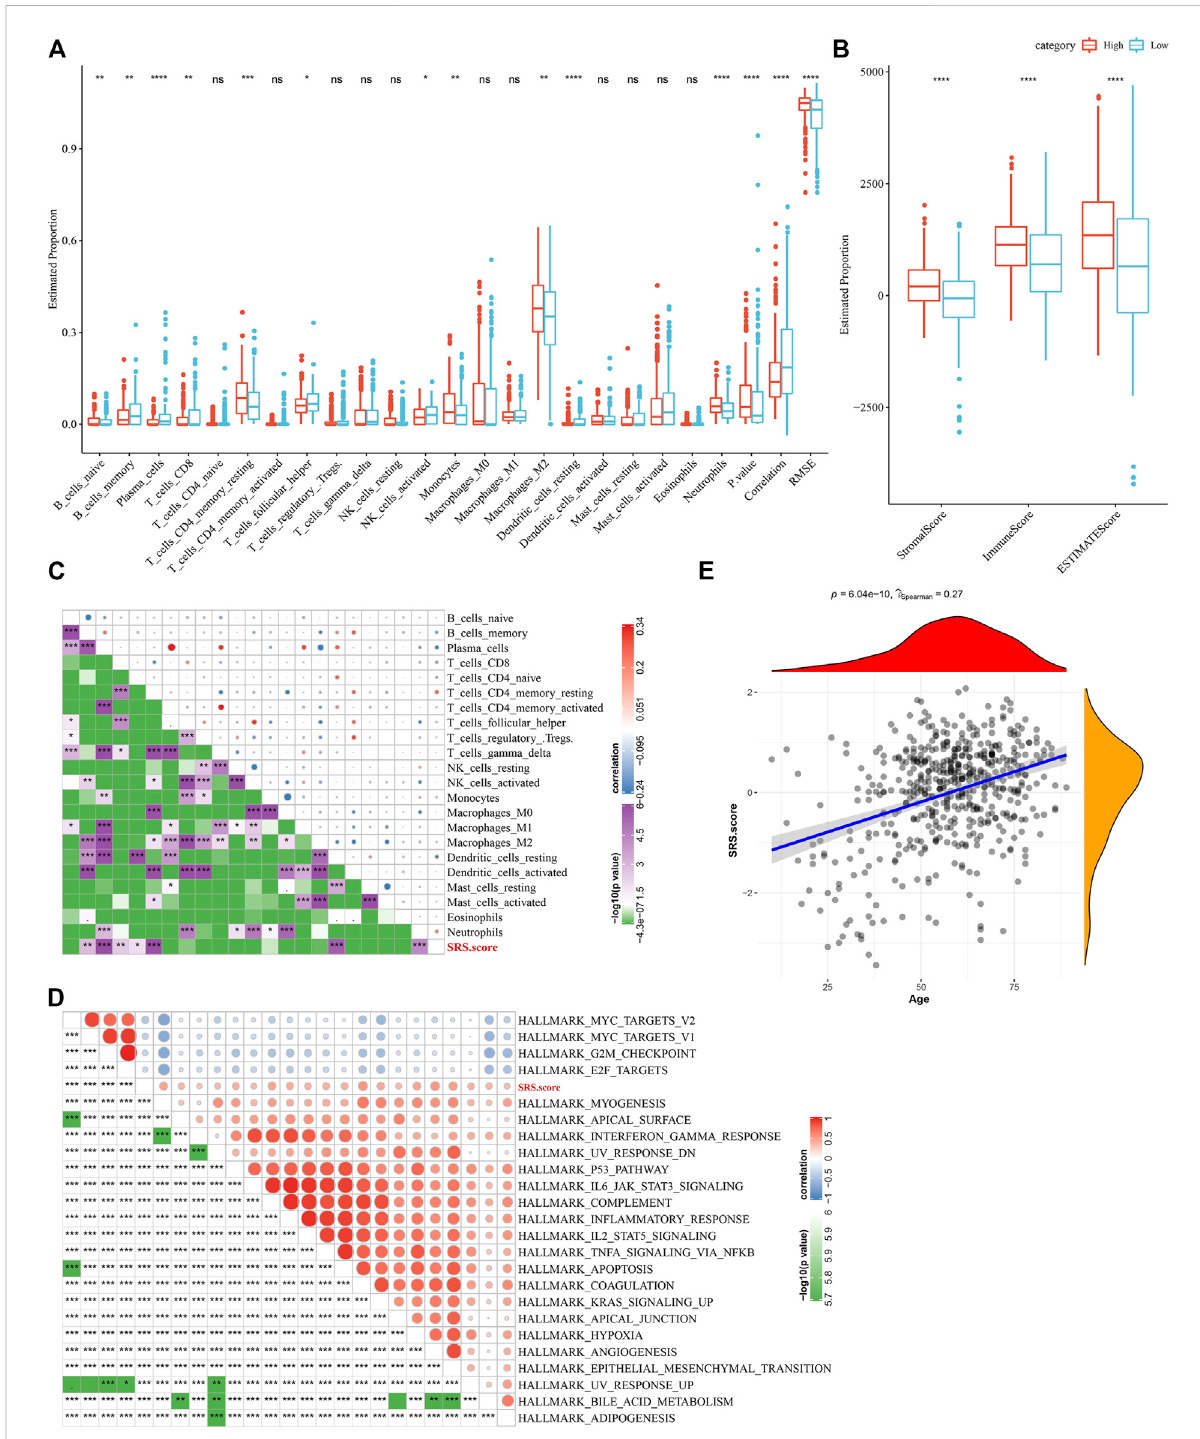
FIGURE 9 Difference between immune in fi ltration and Hallmarker pathway in SRS.score subgroups. (A) The proportion of immunocytes in the TCGA- GBMcohort; (B) TheproportionofimmunocytecomponentscalculatedbyESTIMATE softwareintheTCGA-GBMcohort; (C) Correlation analysisof 22 immune cell components and SRS.score in TCGA-GBM cohort; (D) Results of correlation analysis between KEGG pathway with correlation greater than 0.3 with SRS.score and SRS.score; (E) Analysis of Correlation between Age of Samples and SRS.score in the TCGA-GBM